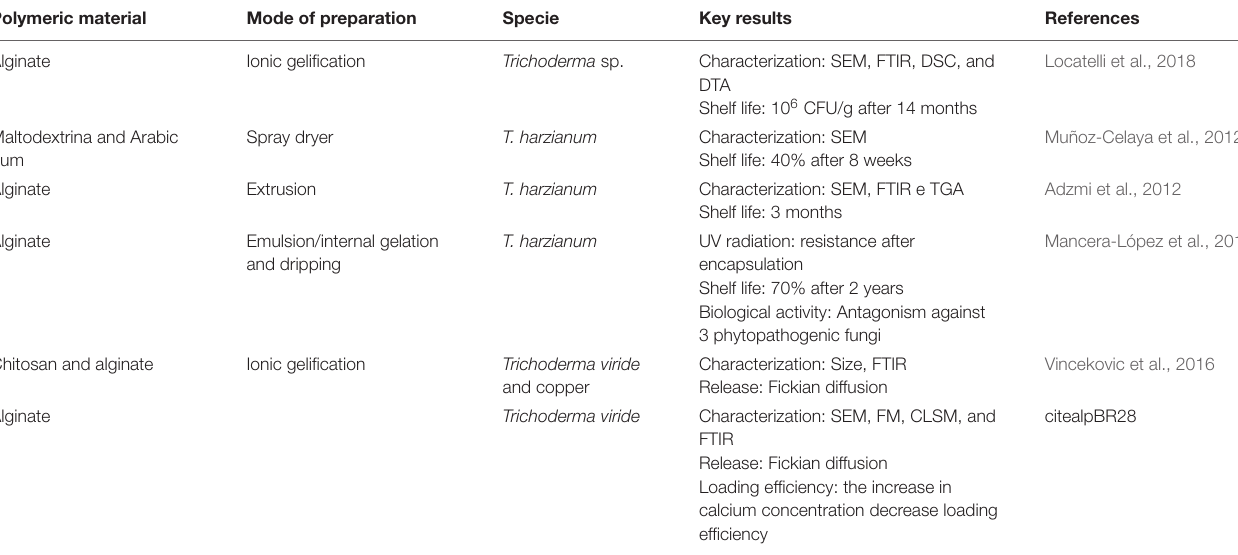
TABLE 1 | Representative list of published papers in literature about microencapsulation and T. harzianum as well as the mode of preparation, used specie and key